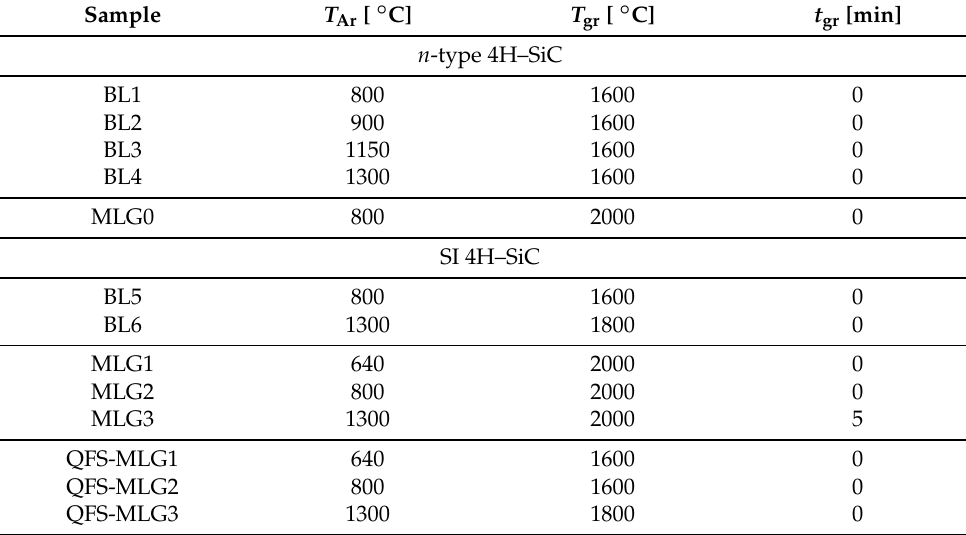
Table 1. Growth conditions of the samples studied in this work: T Ar , T gr and t gr of buffer layer (BL), monolayer graphene (MLG) and quasi-free-standing (QFS)-MLG grown on n -type and semi- insulating (SI)